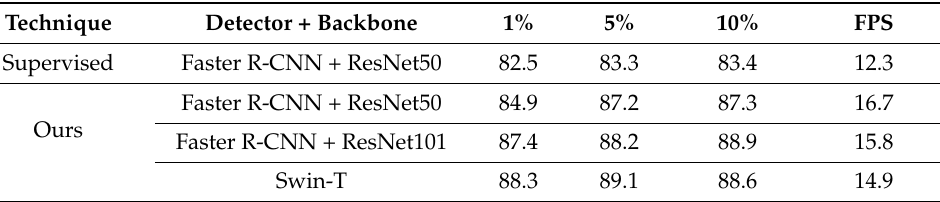
Table 5. Performance mAP (0.5:0.95) comparison of supervised and ours models trained on 1%,5% and 10% of PubLayNet dataset.